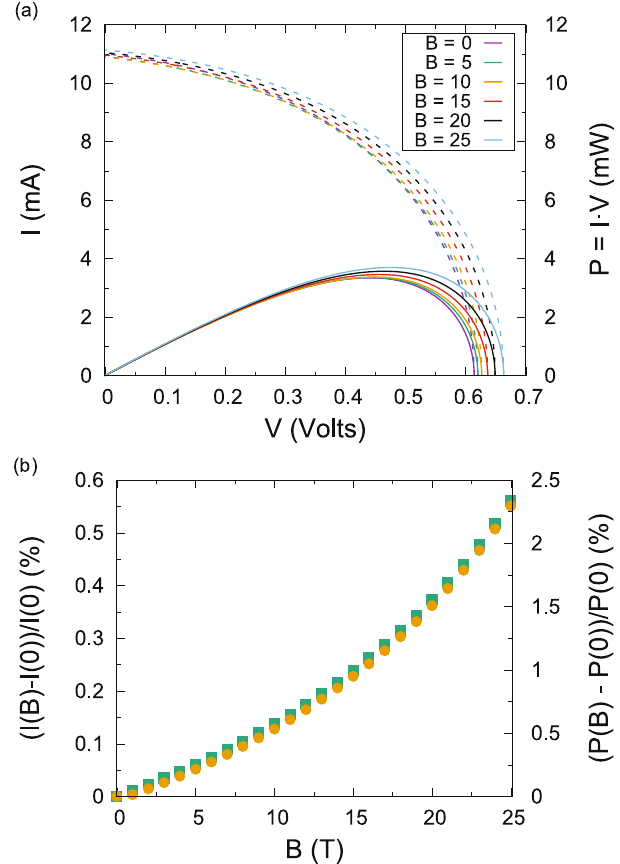
Figure 4. Numerical I–V characteristic (dashed) and power (continuous) of the model solar cell shown in Fig. 2 for different magnitudes of the external magnetic field in (a). Percentage increase in the generated photocurrent across the load calculated for the point of maximum power (squares) and percentage increase of the maximum power outcome (dots) in (b). Geminate recombination and free charge generation both have a 1 ns rate, while non-geminate recombination is 1.5 ns and triplet fusion is 0.5 ns. Triplet exciton formation rate from triplet charge transfer states is here increased to 1.5 nanoseconds. It is demonstrated how the presence of a magnetic field enhances the performance of an organic solar